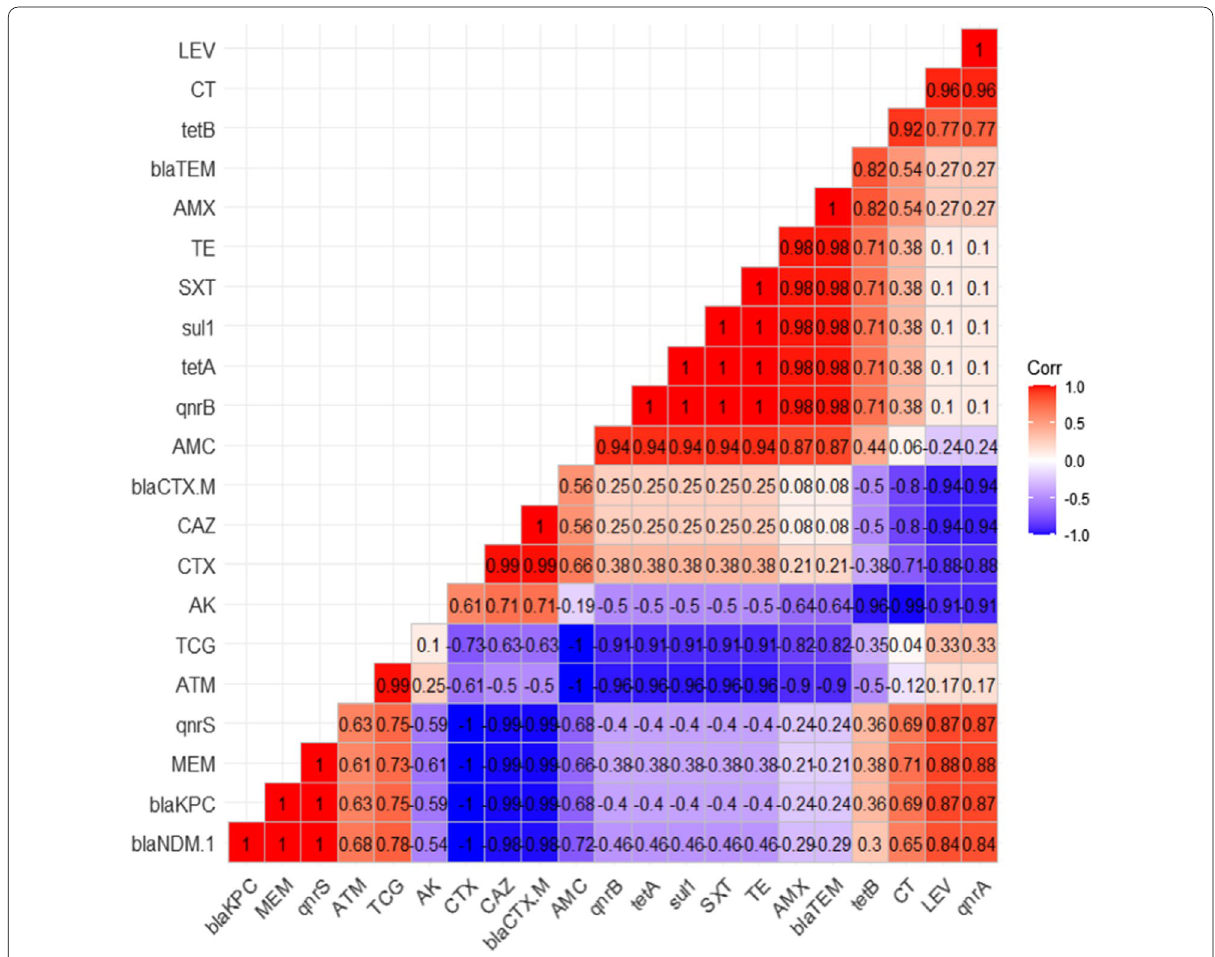
Fig. 5 The heat map shows the correlation between the phenotypic antibiotic‑resistant and corresponding